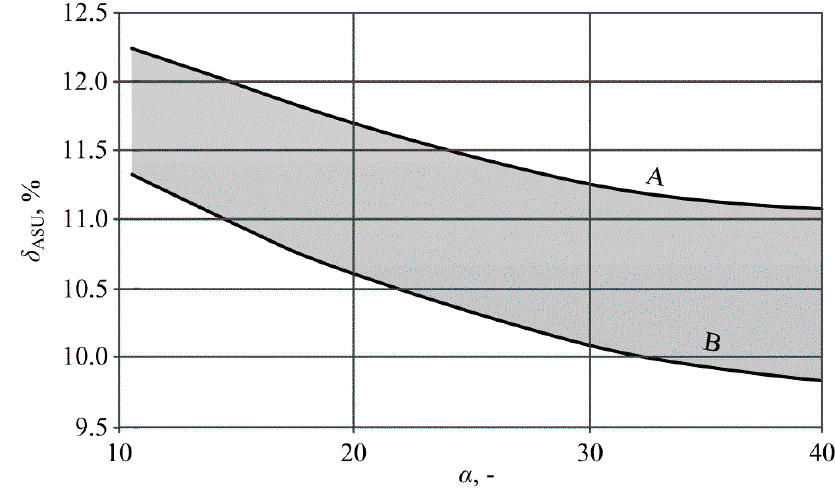
Figure 10. Variant V2 power plant ASU auxiliary power rate as a function of the O 2 /N 2 membrane selectivity coefficient.